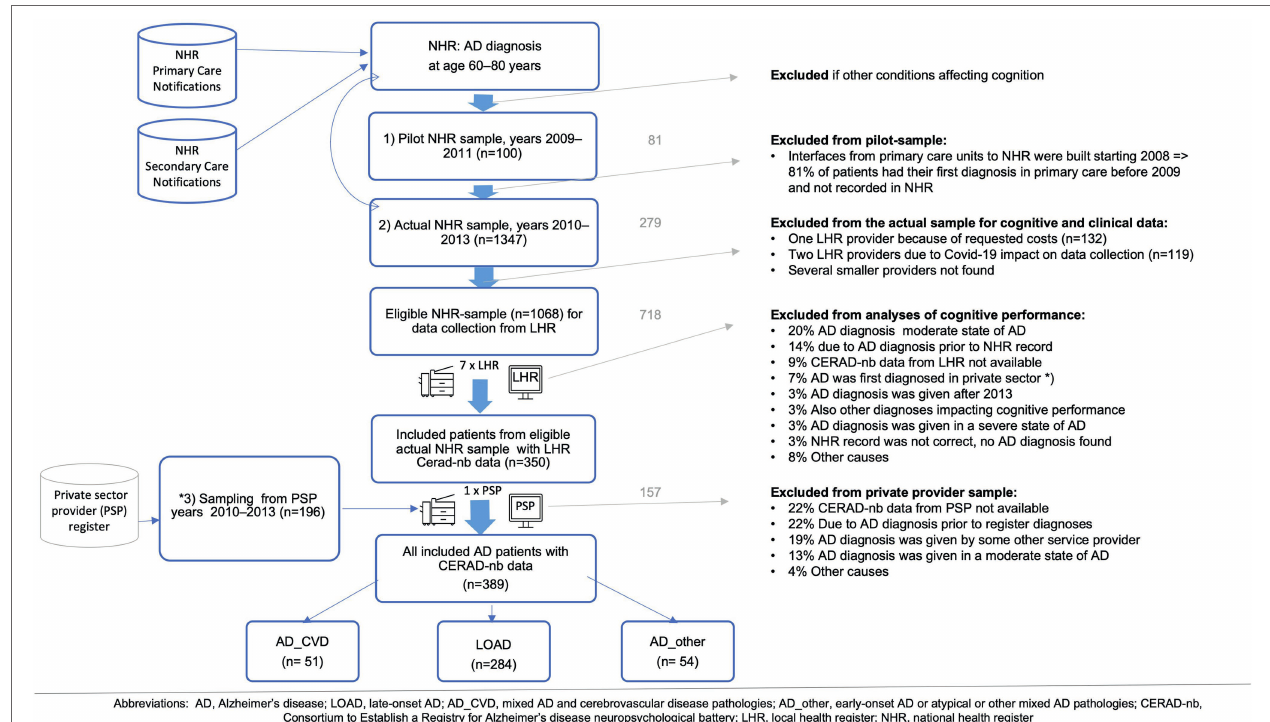
FIGURE 1 | Sampling of patients with Alzheimer’s disease (AD)